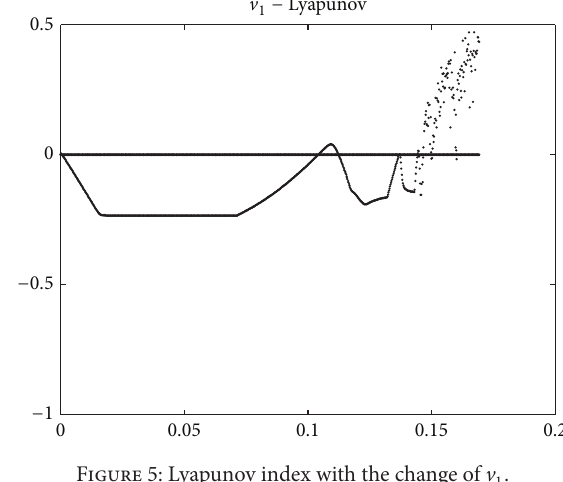
Figure 2: Quantity bifurcation with the change of V 1 .